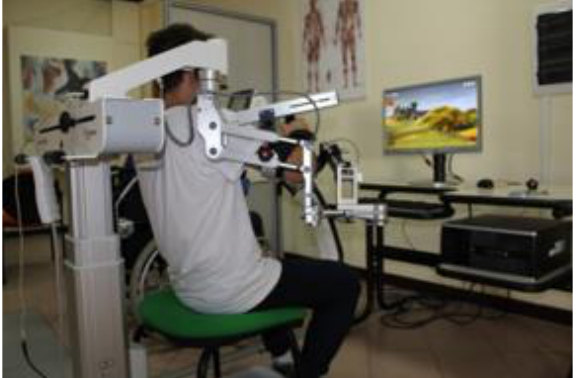
Figure 2. A patient with PD receiving the experimental training with the Armeo©Spring